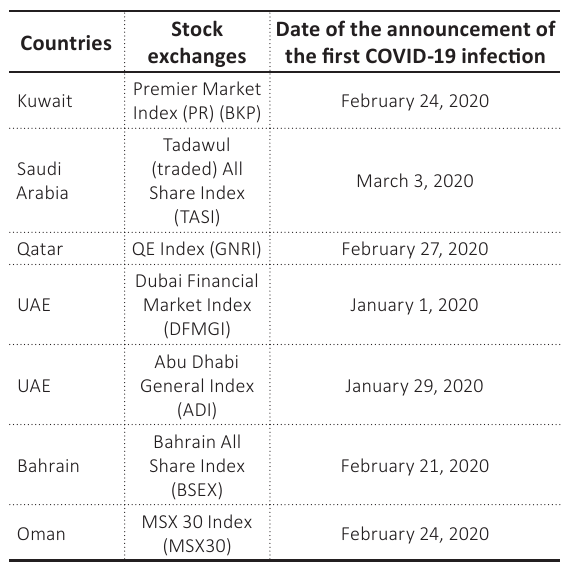
Table 1. The stock exchange market indexes and the announcement of the first COVID-19